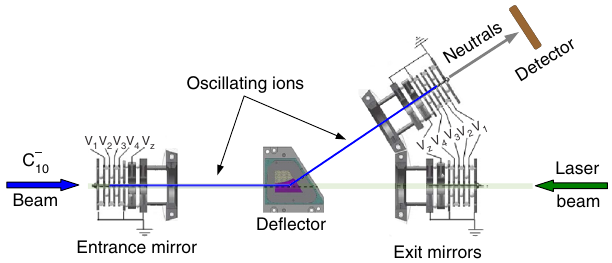
beam is trapped Fig. 1 Schematic of the experimental setup. The C (cid:1) 10 oscillating between the entrance mirror and the exit mirror in the bent section of the electrostatic ion beam trap (EIBT) by applying a speci fi c set of voltages to the mirror electrodes and to the electrostatic de fl ector. A laser pulse of ~5 ns duration is admitted through the linear section of the EIBT and merged with the trapped C (cid:1) ions. Neutrals produced promptly 10 after laser interaction fl y out of the setup from the linear section and are not detected. Neutrals produced after the ions are de fl ected towards the bent section by the de fl ector, i.e., after a delay of at least a few microseconds after the interaction with the laser, fl y out of the bent section exit mirror and are detected by a microchannel plate (MCP) detector and counted as a function of trapping